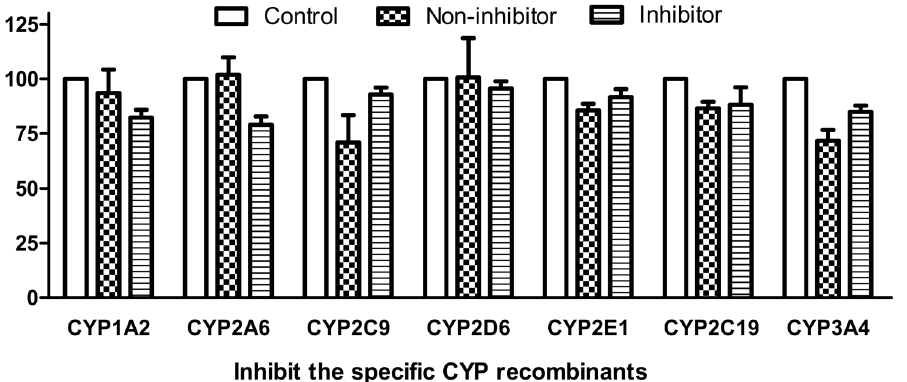
Fig 4. Effect on the metabolic clearance rate (MCR) of CK under the inhibition of recombinant CYP2C9 and CYP3A4. Note: About 50 μ M of CK was incubated with the CYP recombinants and cofactors in the absence (control) or presence of the inhibitors by sulfaphenazole (1 μ M) and ketoconazole (1 μ M), respectively. Each point represents the average of triplicate incubations. The MCRs of CK were significantly decreased compared with those of the control for CYP3A4 and CYP2C9.